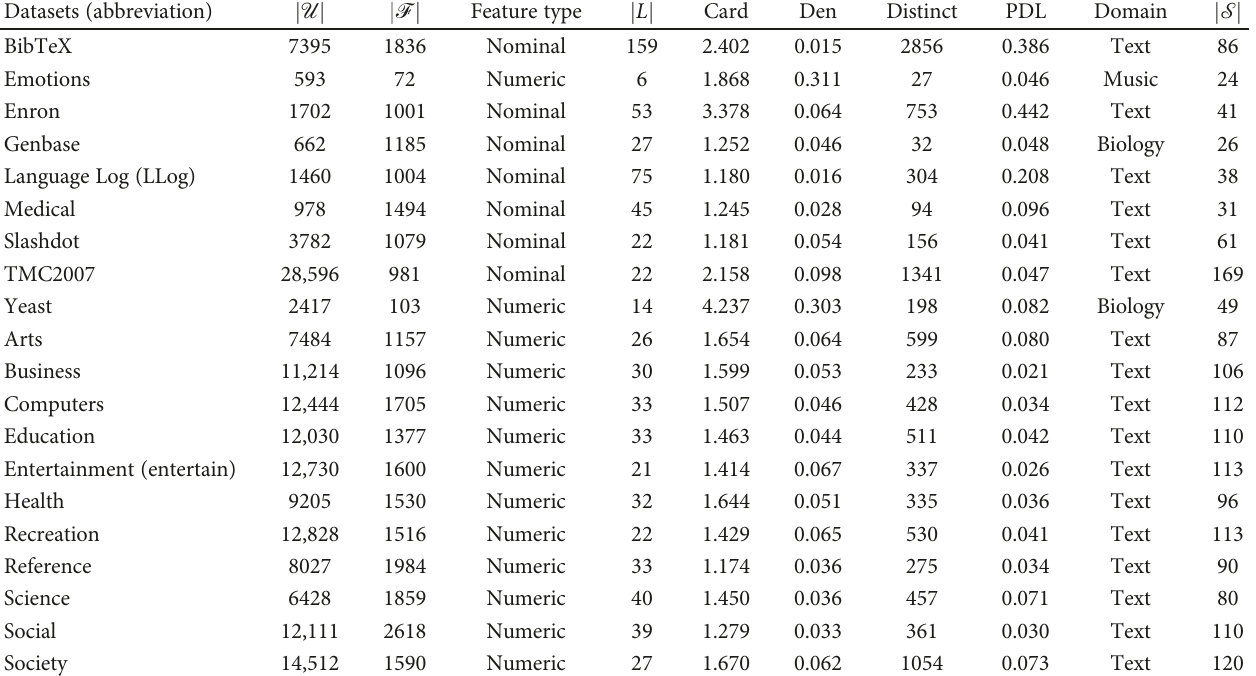
Table 1: Standard characteristics of multilabel datasets.